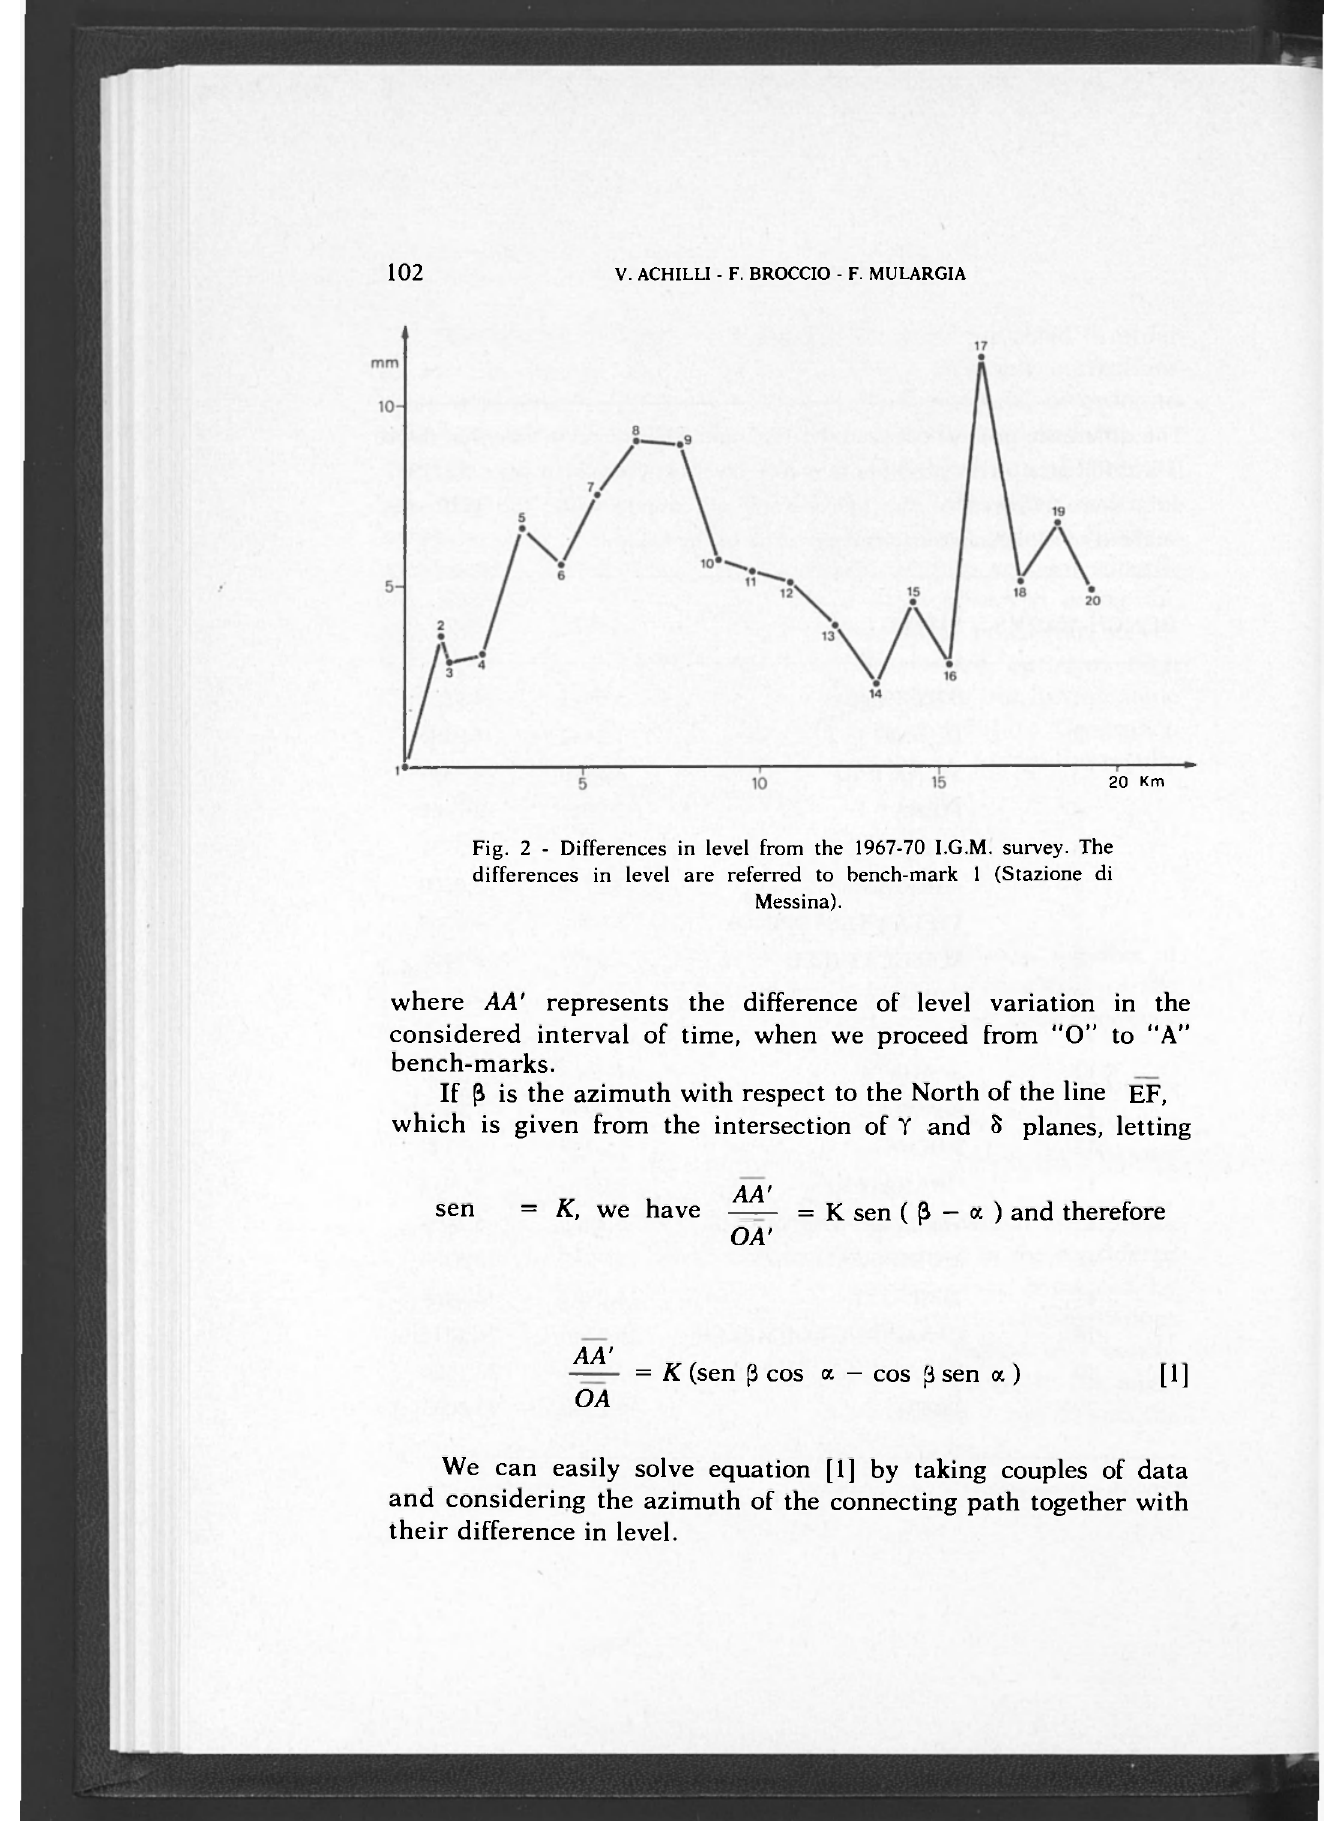
Fig. 2 - Differences in level from the 1967-70 I.G.M. survey. The differences in level are referred to bench-mark 1 (Stazione di Messina).